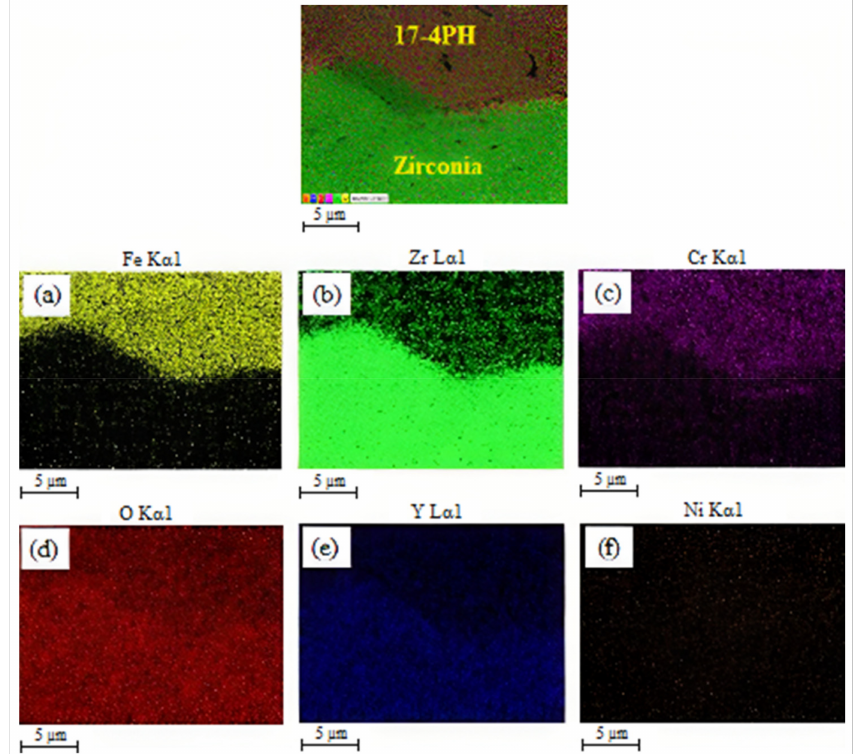
Figure 10. EDS mapping displaying the bonded 17-4PH/zirconia micro-sized component and proportions of ( a ) Fe element; ( b ) Zr element; ( c ) Cr element; ( d ) O element; ( e ) Y element; ( f ) Ni element present across the